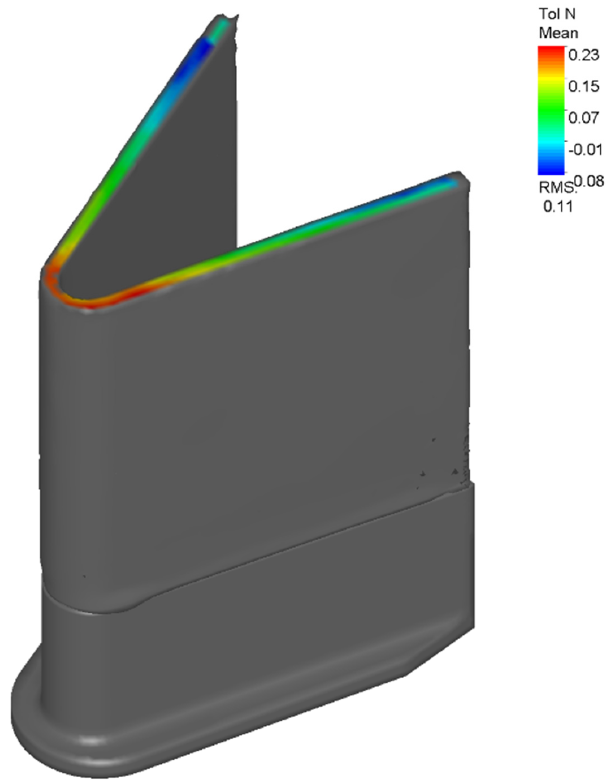
Figure 8. A contour plot showing the area that is used to calculate the RMS value. Grey areas do not affect the RMS value.